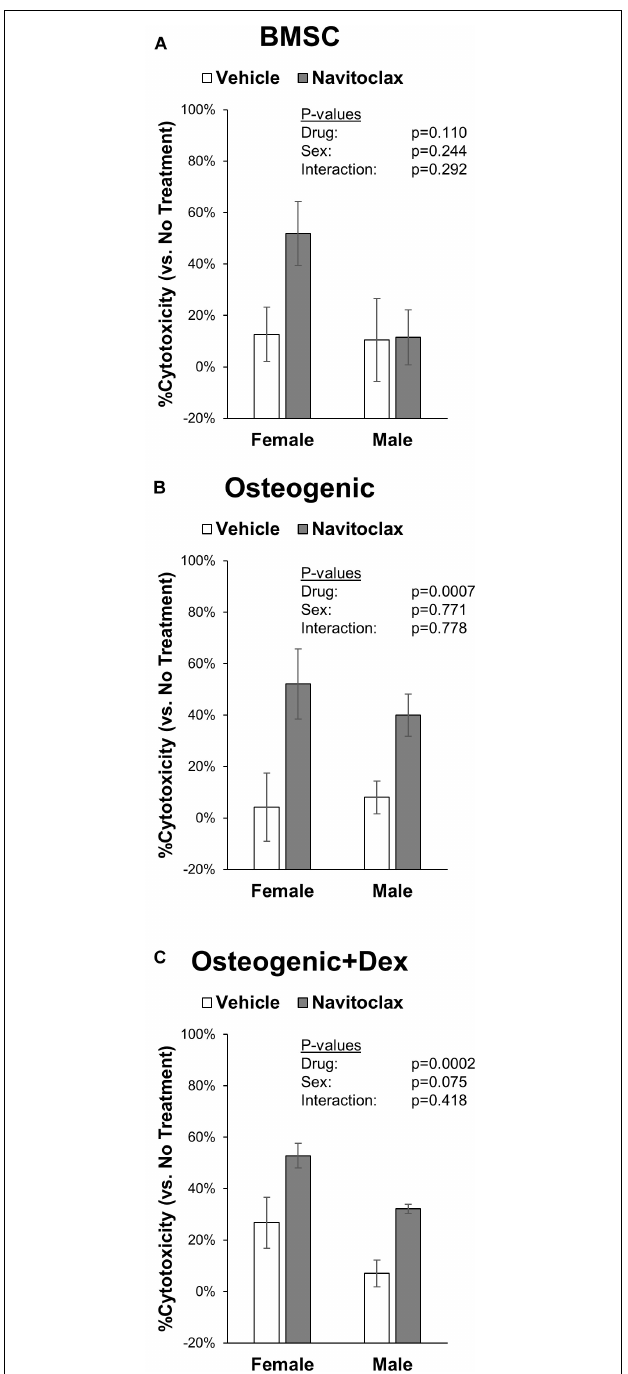
FIGURE 4 | Navitoclax has cytotoxic effects in osteogenic cultures. Primary BMSC were treated with navitoclax (5 µ M) or vehicle (DMSO) in BMSC growth medium (A) , osteogenic medium (B) , or osteogenic medium with 100 nM dexamethasone (C) . Cellular metabolic activity was quantified in MTT assays, and cytotoxicity for each treatment was calculated relative to untreated cells for each condition P -values shown represent statistical comparisons between groups, p -value for “drug” in 2-factor ANOVAs represents the comparison between navitoclax (gray) and vehicle (white)-treated cultures.